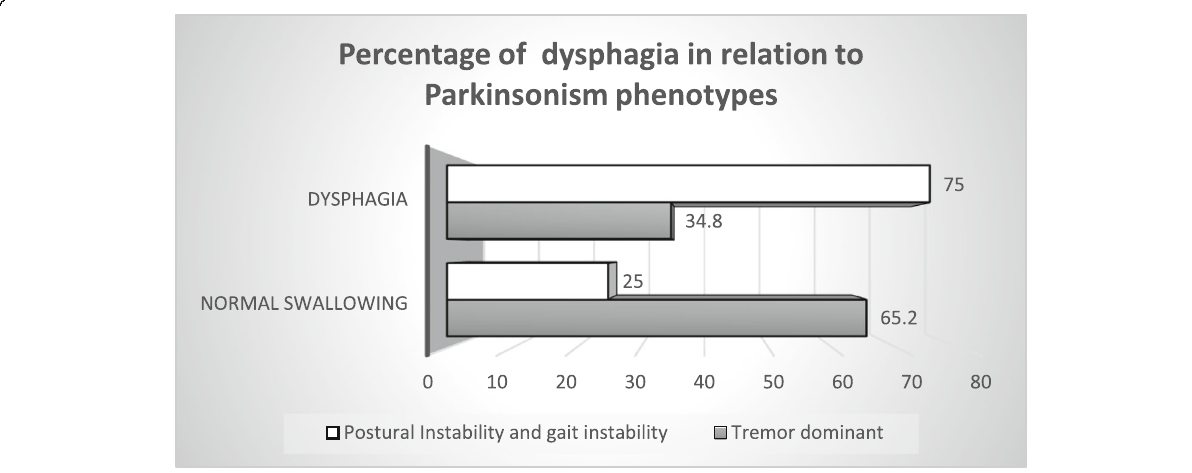
Fig. 2 Percentage of dysphagia in relation to parkinsonism phenotypes